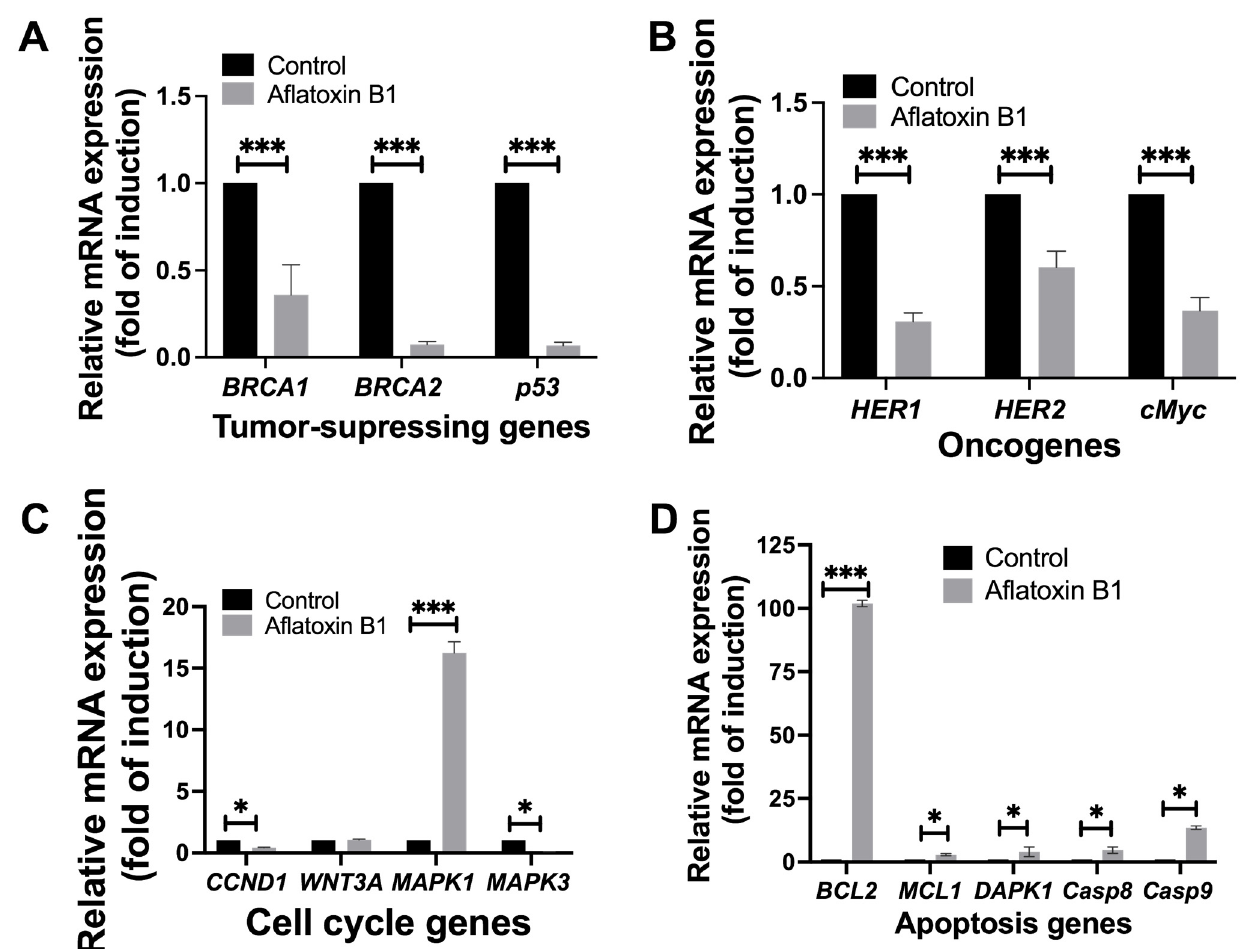
Figure 9. The effects of aflatoxin B1 on tumor-related gene expressions like tumor suppressing ( A ), onco- ( B ), cell cycle ( C ), and apoptosis ( D ) genes in MCF10A cells. * p < 0.05 and *** p < 0.001 compared to control.